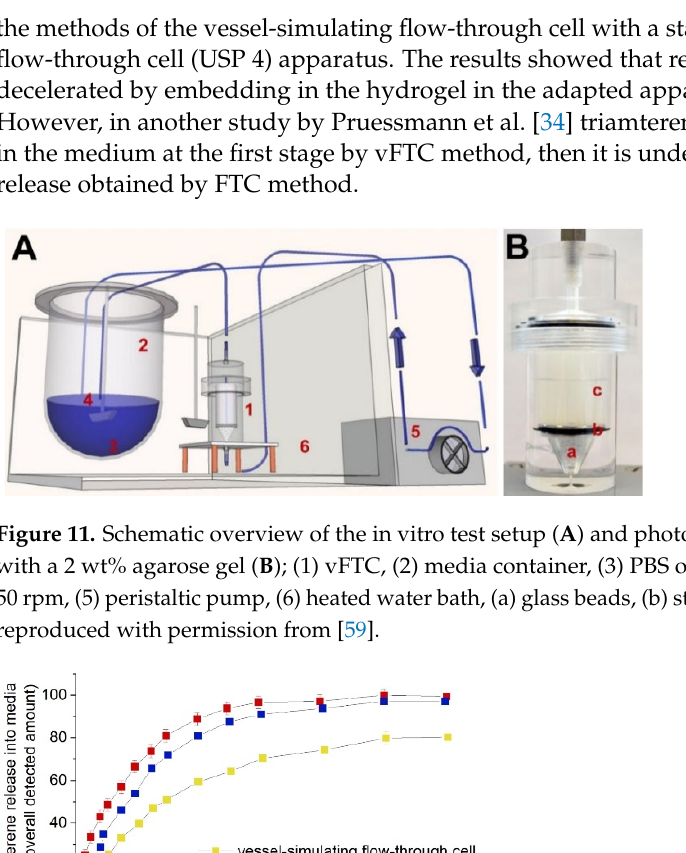
Figure 12. Normalized release of triamterene from stent coatings into media over time with vessel-simulating flow-through cell, flow-through cell (USP 4), or paddle apparatus (USP 2); flow rate 35 mL/min, paddle speed 50 rpm, reprinted from [85].